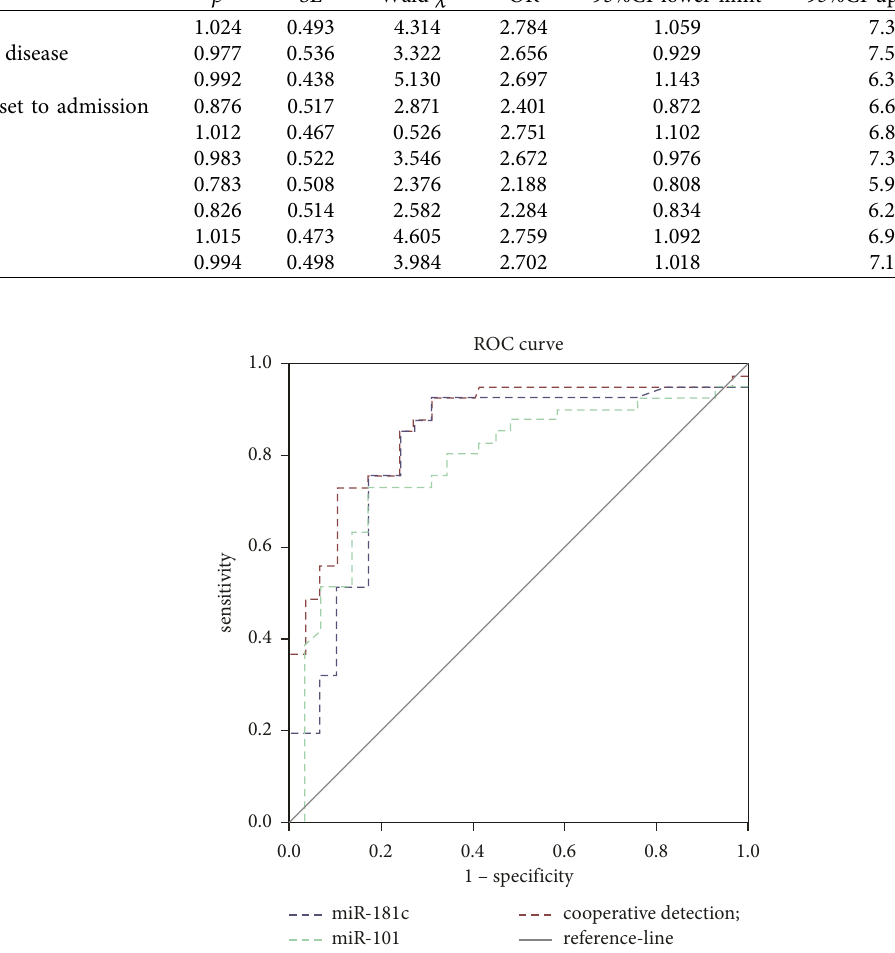
Figure 3: ROC curves of peripheral blood miR-181c and miR-101 in the diagnosis of CI in patients with DM complicated with AS.